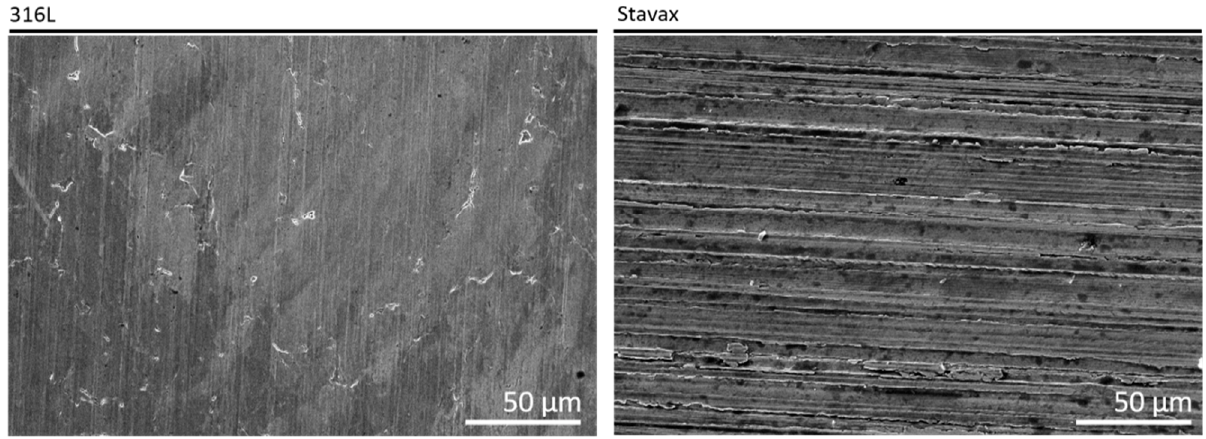
Figure 1. Initial roughness of the material for ( left ) flat stainless steel 316L samples with Sa 0.16 µm and ( right ) for Stavax with Sa 0.50 µm. and ( right ) for Stavax with Sa 0.50 µ Table 1. Chemical composition (mass fractions in %) for stainless steel samples and Stavax.